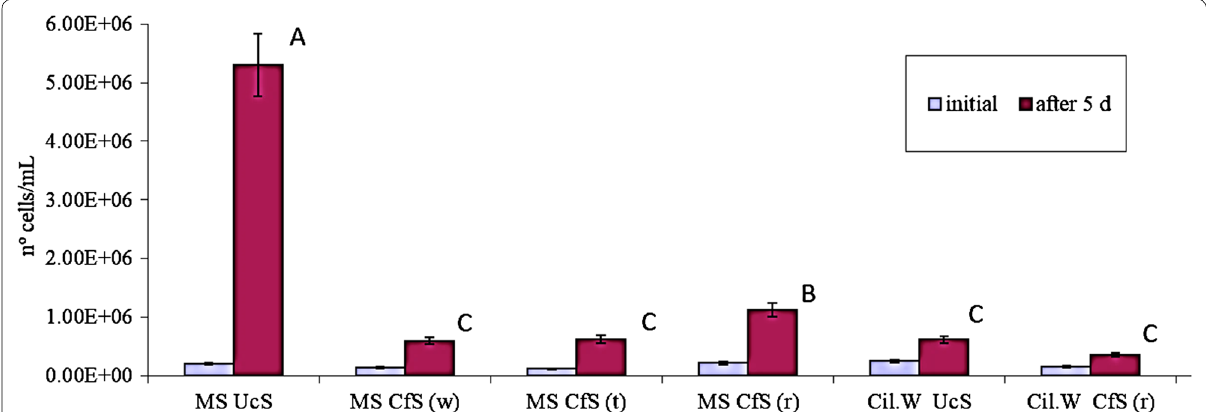
Fig. 2 Cell number of C. vulgaris growing in Erlenmeyers. Initial and final cell numbers after a growth period of 5 days were determined as described in “Materials and methods”. MS UcS unconfined system in Murashigue Skoog (MS) growth medium, MS CfS (w) confined system in MS growth medium (white PLA device), MS CfS (t) confined system in MS growth medium (translucent PLA device), MS CfS (r) confined system in Cidáñez stream water (red PLA devices), Cil.W UcS unconfined system in Cidáñez stream water, Cil.W CfS (r) confined system in Cidáñez stream water (red PLA devices). Mean data from three independent experiments are shown. Letters indicate significant differences for the same substrate (p < 0.05)